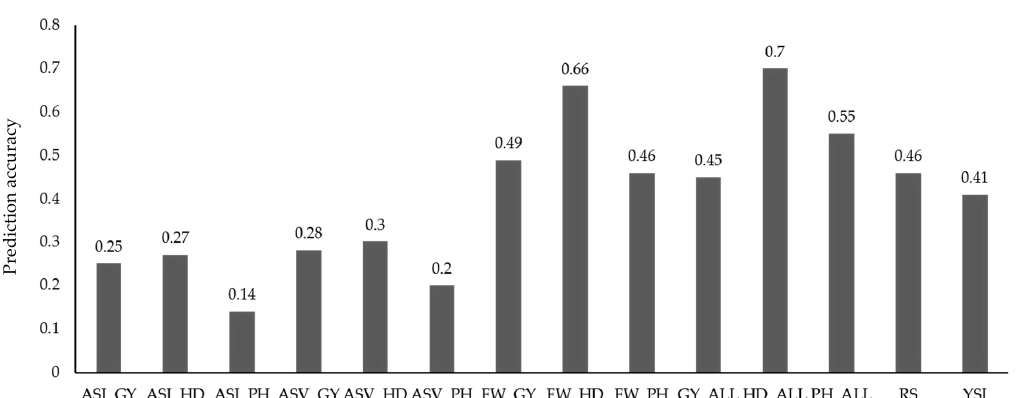
Figure 3. Mean prediction accuracy for trait and trait stability indices for grain yield, heading date, and plant height. ALL, BLUP values of trait across all environments; ASI, AMMI stability index; ASV, AMMI stability value; FW, Finlay ‐ Wilkinson regression; RS, rank sum; YSI, yield stability index.